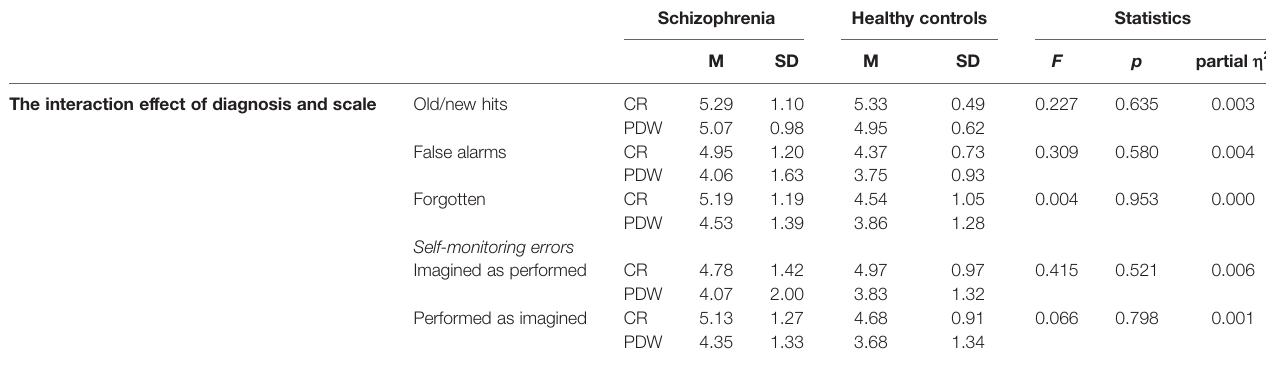
TABLE 8 | The interaction effect of type of scale (CR vs. PDW) and diagnosis (Schizophrenia vs. Healthy controls) on con fi dence